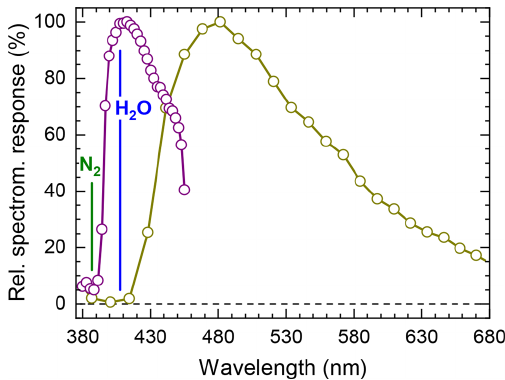
Figure 2. Relative calibration of the UVA spectrometer (violet curve) and the VIS spectrometer (dark yellow curve). Symbols in- dicate center wavelengths of the individual detectors. Raman Q branch wavelengths of molecular nitrogen and water vapor are marked for